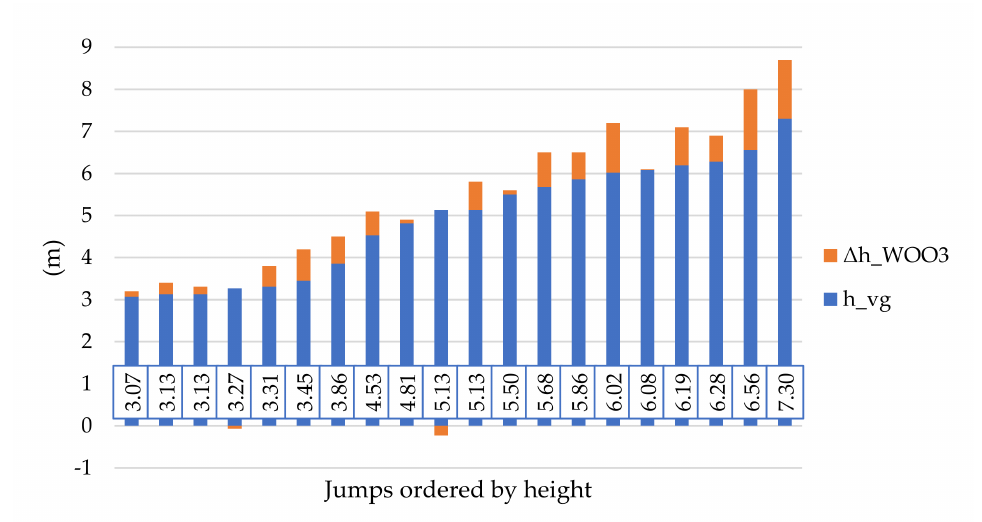
Figure 11. Jump heights determined videogrammetrically and corresponding differences related to WOO3